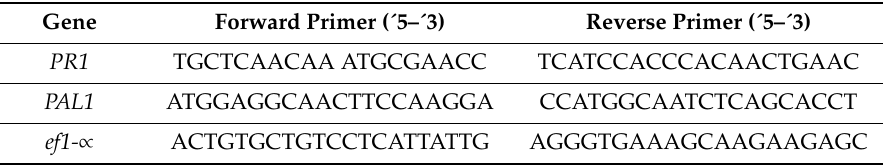
Table 2. Forward and reverse primers sequence for PR1, PAL1 and ef1- ∝